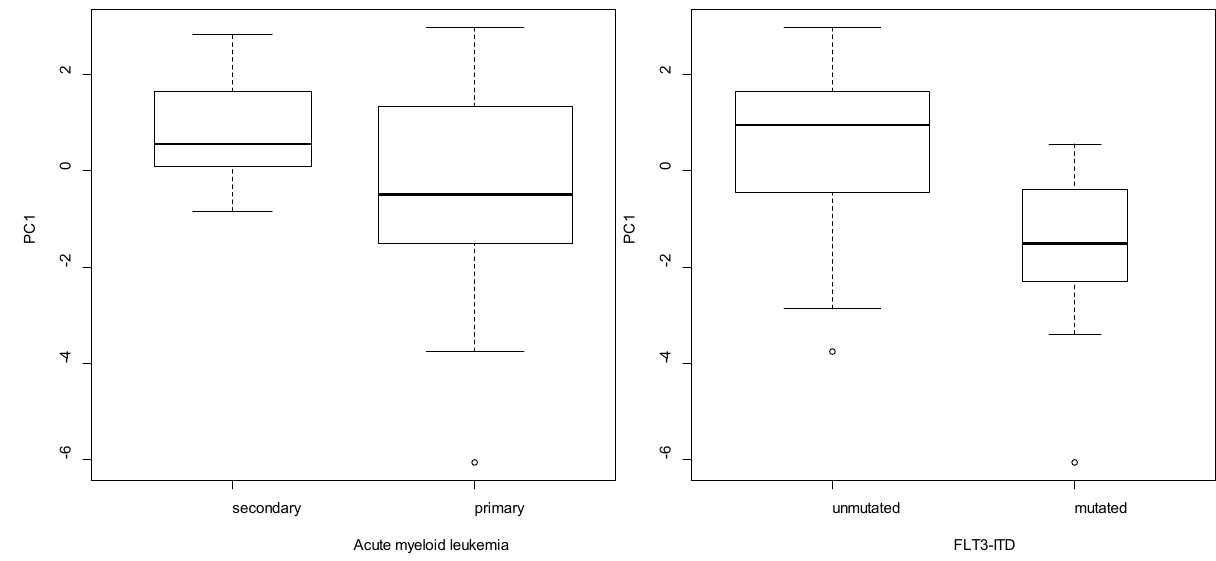
Fig. 2. The association of PC1 with FLT3-ITD ( P = 0.0017) and secondary AML origin ( P =